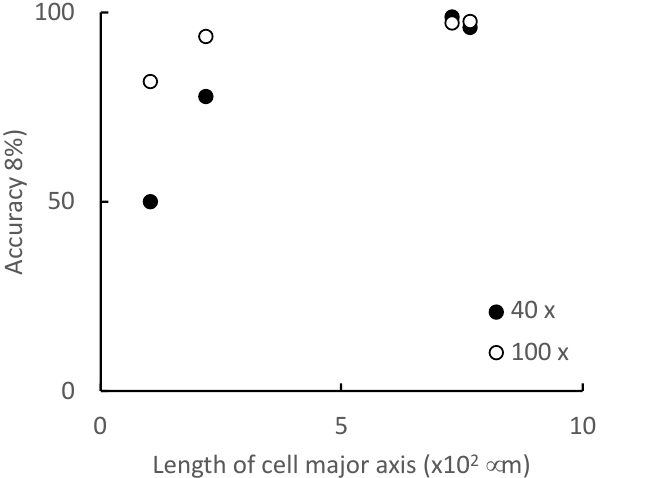
Figure 8. Discrimination accuracy of each microscopic image dataset using our CNN model.